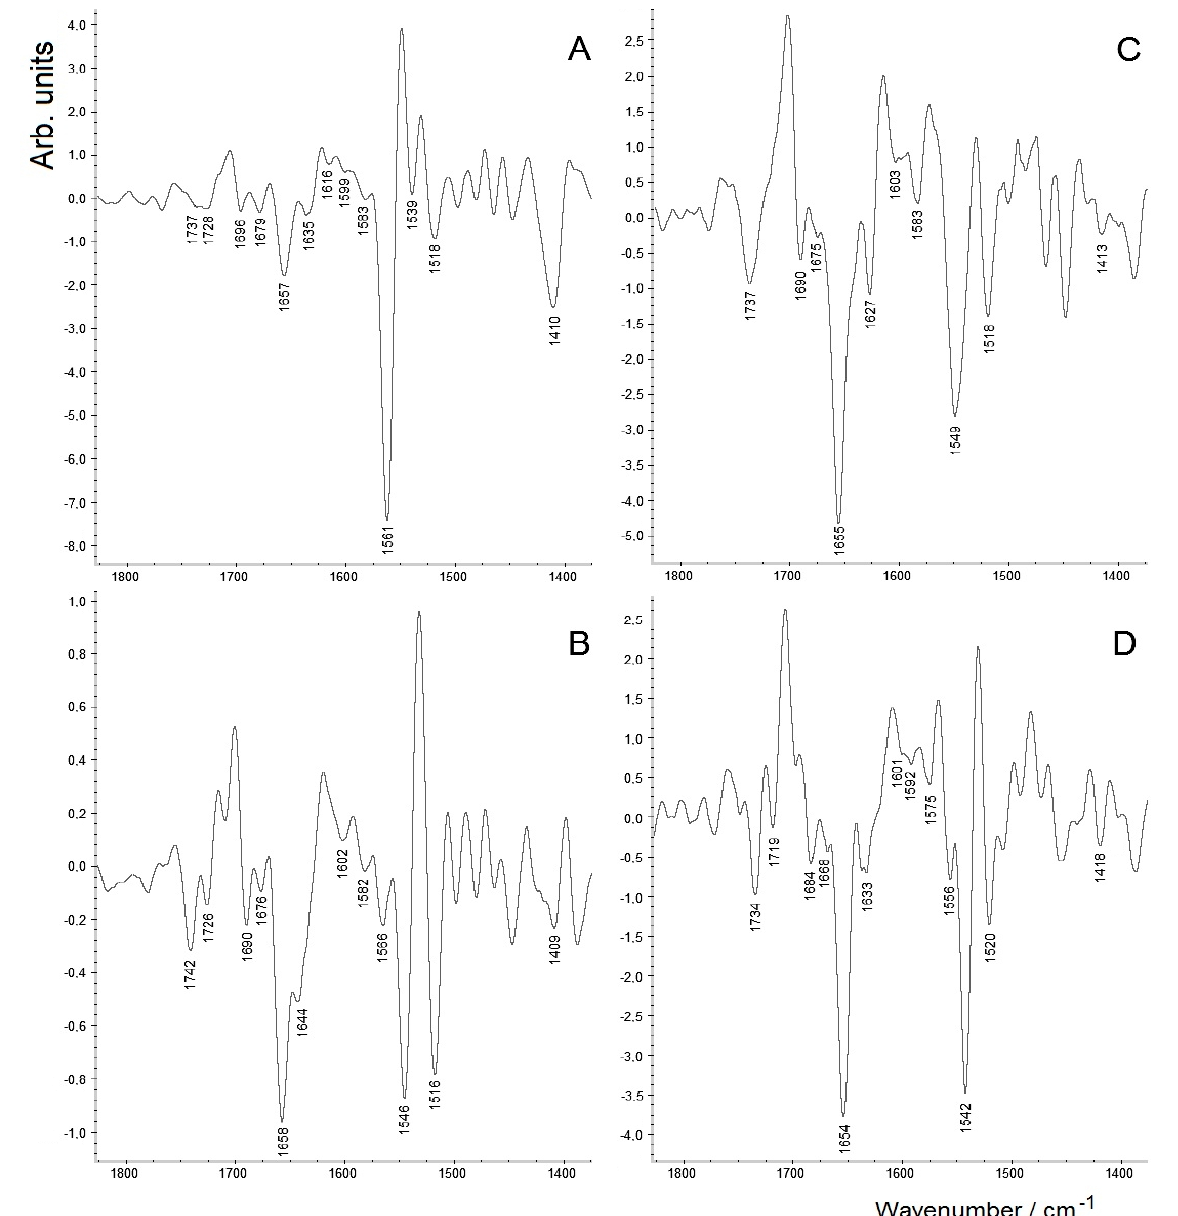
Figure 6. Second derivatives of FTIR spectra of isolated biogenic SeNPs obtained using A. brasilense Sp7 (see Figure 5) measured without washing ( A ) and after 1 ( B ), 2 ( C ) and 3 ( D ) washing steps.